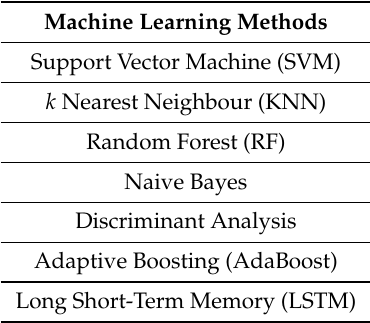
Table 3. Seven state-of-the-art machine learning methods used in the proposed boosting